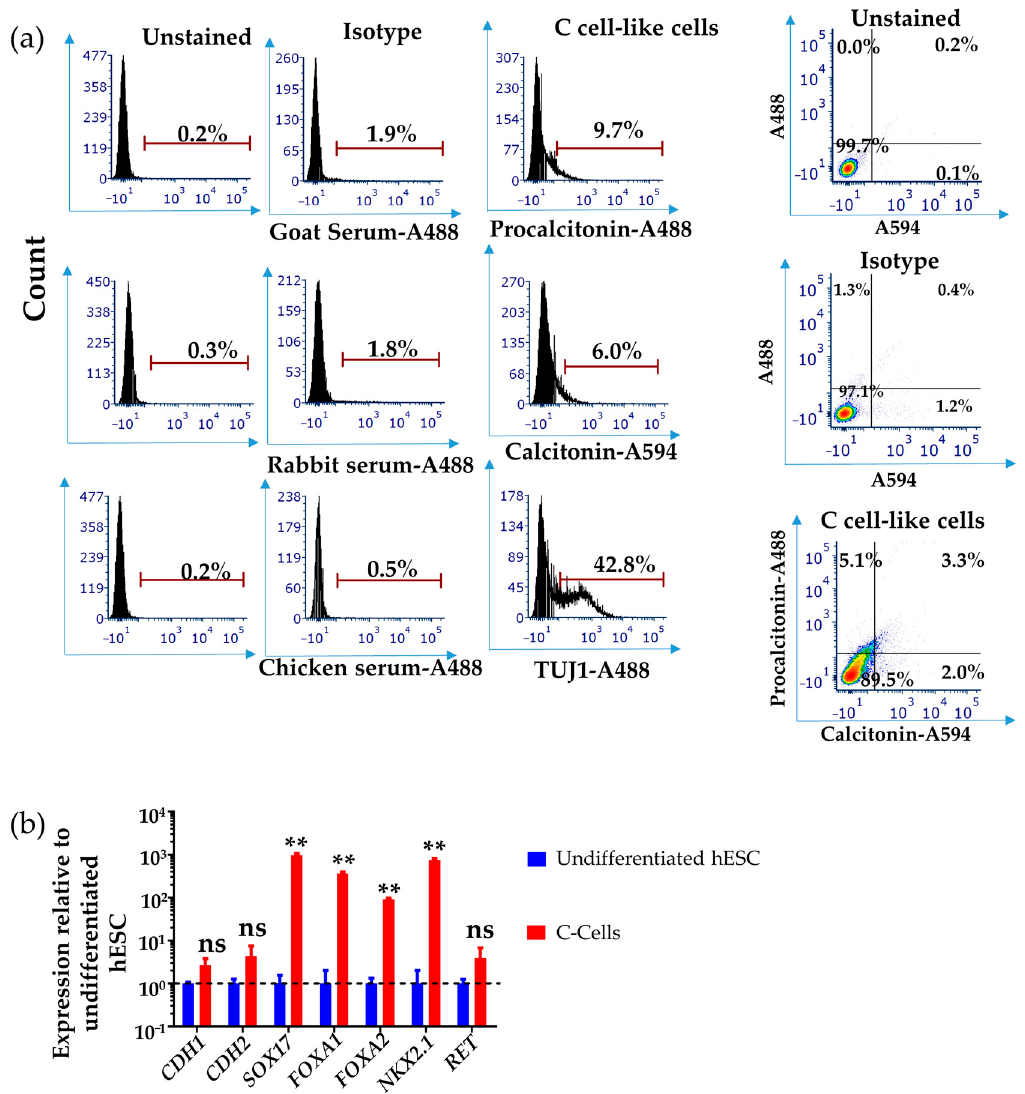
Figure 3. hESC-derived cells express thyroid C cell markers. ( a ) Representative FACS plots of H9 hESC-derived DE/AFE cells differentiated to thyroid C cell-like cells after 3 days of exposure to IGF-1 as analysed using PROCALCITONIN, CALCITONIN, and TUJ1 antibodies. The plot suggests emergence of PROCAL+/CALC+ sub-populations after 3 days of IGF-1 exposure while more than 40% of the cells express TUJ1, a neuronal marker expressed in C cells. ( b ) qPCR analysis of day 15 differentiated thyroid C cell-like cells (red bars) comparing the expression of C cell markers, normalised to undifferentiated hESC (H9, blue bars). Error bars represent mean ± SEM. n.s., not significant, ** p < 0.01. n = 3 independent experiments. Human embryonic stem cells